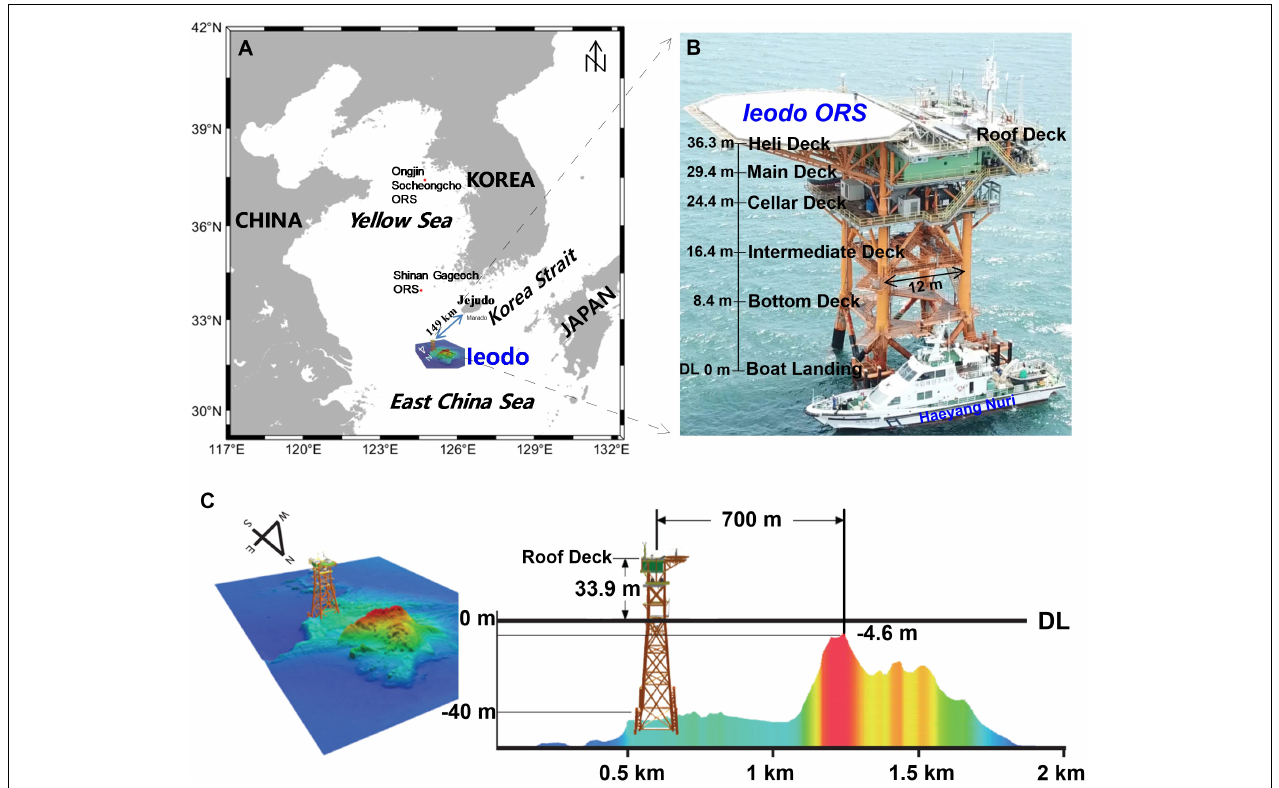
FIGURE 1 | (A) Location map of Ieodo Ocean Research Station (Ieodo ORS); (B) bathymetry around Ieodo ORS; and (C) bathymetric cross section including Ieodo ORS and Ieodo (rock formation). DL stands for datum level, which is the Approximate Lowest Low Water (1.35 m below mean sea